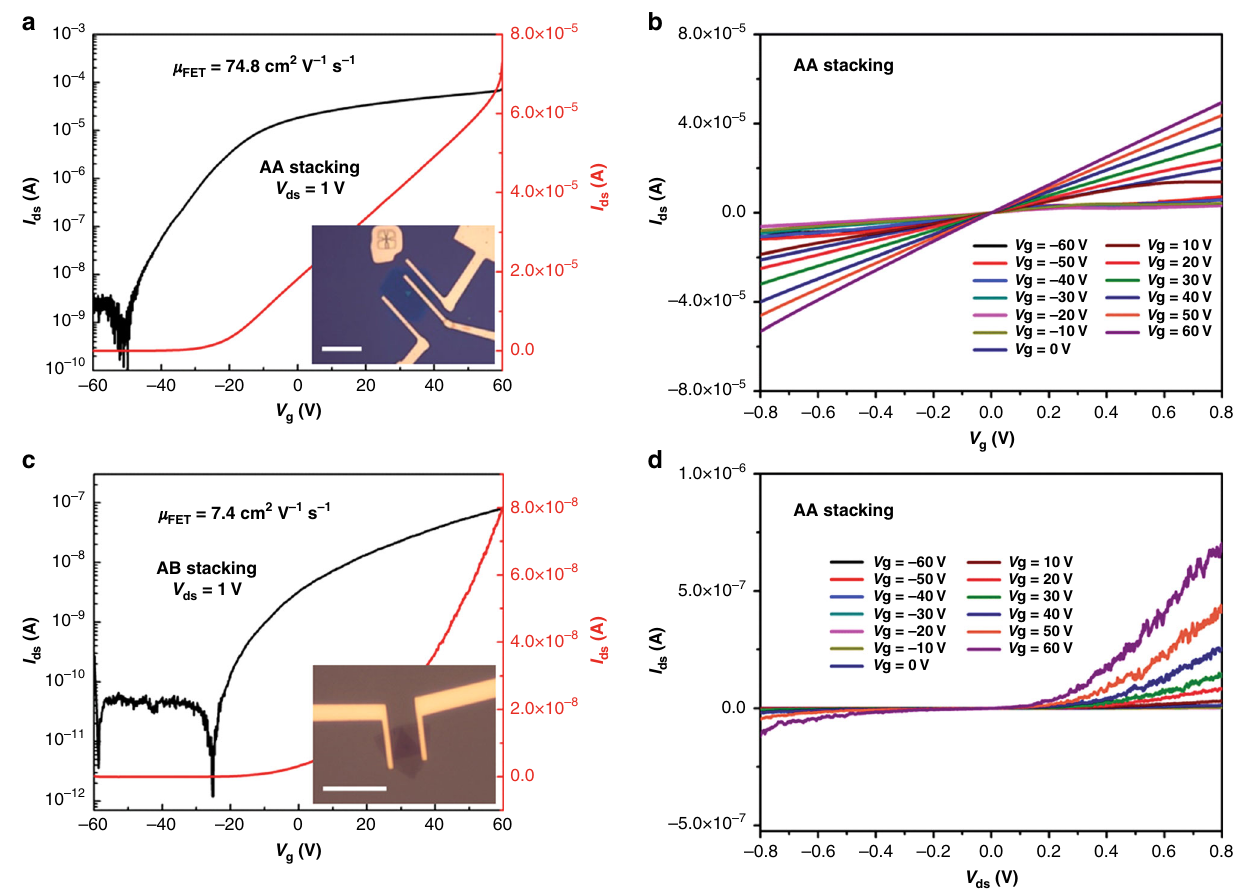
Fig. 5 Electrical properties of the bilayer MoS 2 FET devices. The representative transfer characteristics ( I DS − V g ) and output characteristics ( I DS − V DS ) for a , b AA and c , d AB stacking bilayer MoS 2 FET devices. Insets in a and c are the optical images of the AA and AB stacking bilayer MoS 2 devices, respectively. Scale bars are 10 μ m in the insets of a and